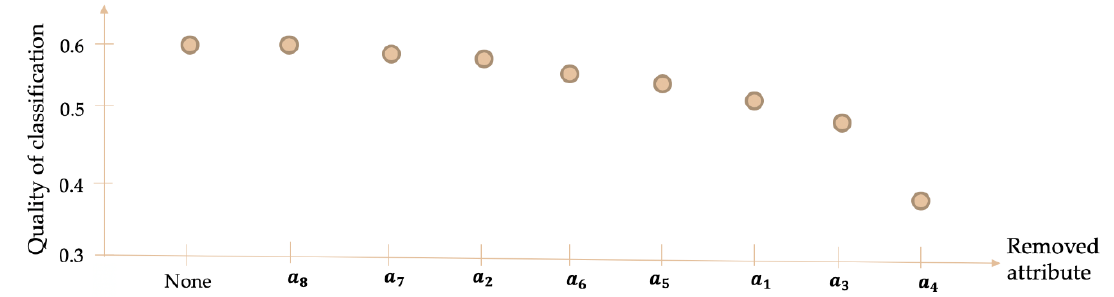
Figure 1. Quality of classification according to removed attributes. 365